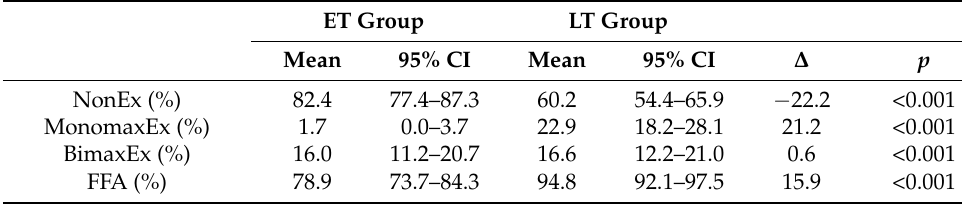
Table 2. Percentage of extraction and full fixed appliance (FFA) need.